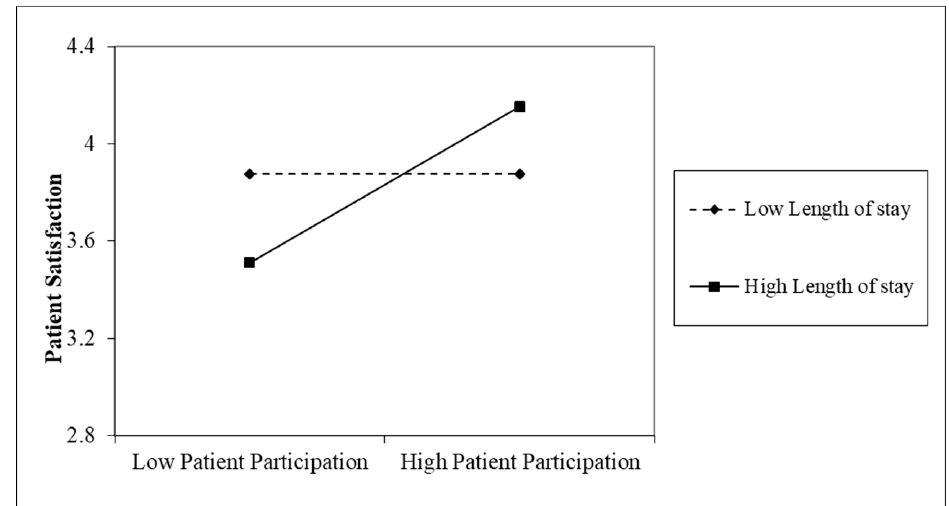
Figure 2. Simple slopes for the interaction between patient participation and length of stay on patient satisfaction. Table 5. Interaction between patient participation and nurse sociodemographic on job satisfaction.